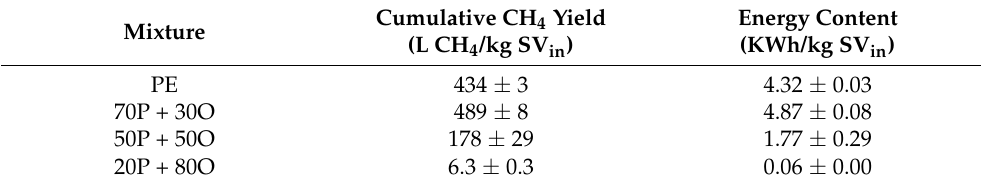
Table 8. Energy potential of PE + OMW mixtures used as feedstock in anaerobic digestion.